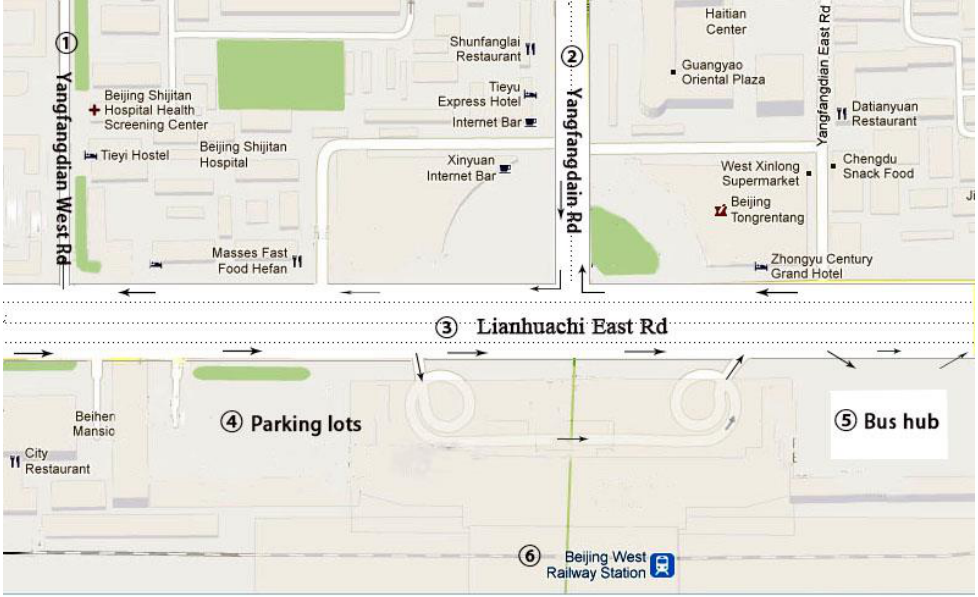
Figure 1. Beijing West Railway Station north area